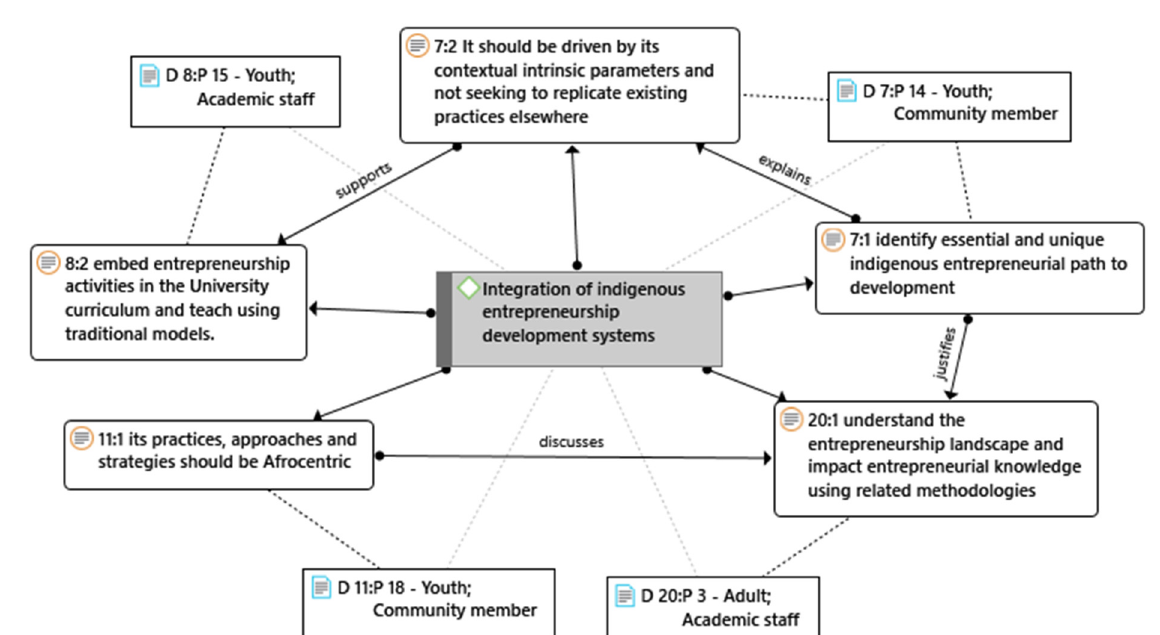
Figure 2. Integration of indigenous entrepreneurship systems.